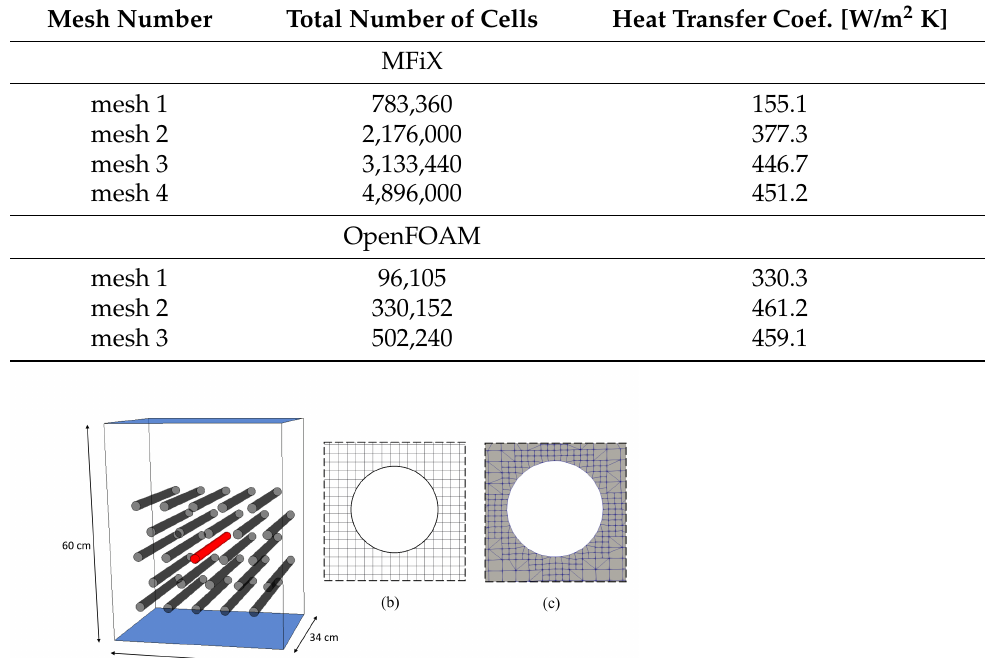
Table 5. Grid refinement analysis for MFiX and OpenFOAM for Test 3.